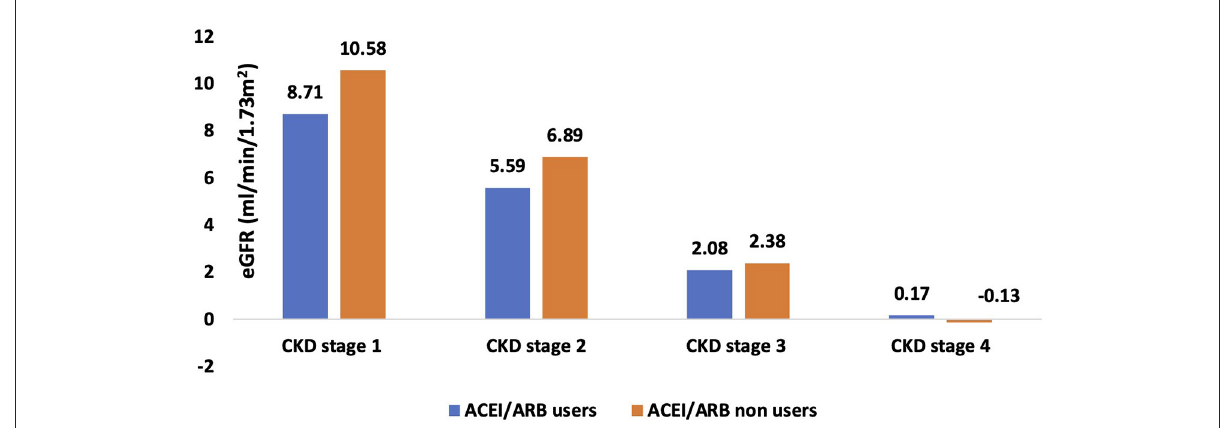
FIGURE2 Bar graph representing annual mean eGFR decline in CKD stage 1–4 in ICKD cohort.